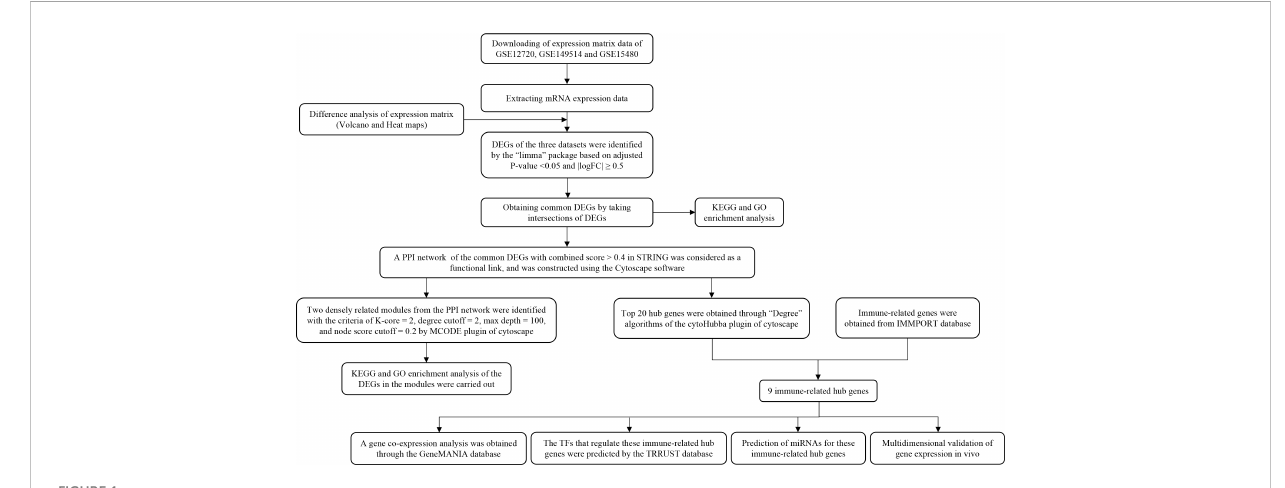
FIGURE 1 Schematic representation of the research